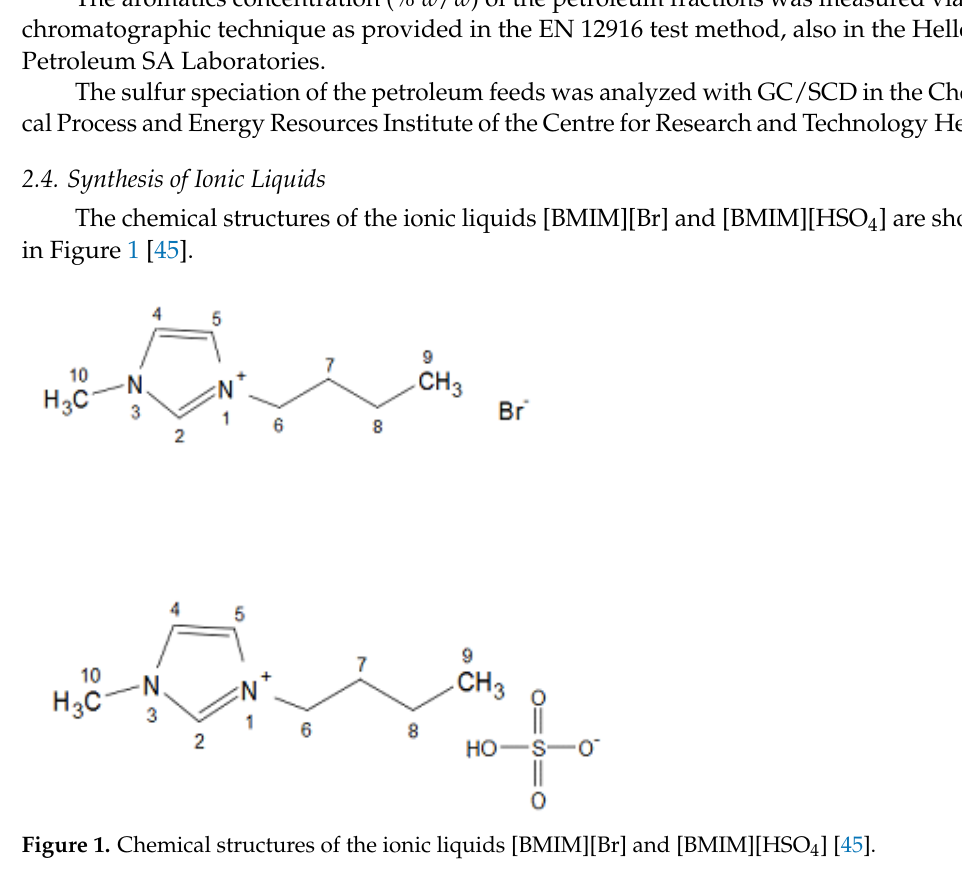
Figure 1. Chemical structures of the ionic liquids [BMIM][Br] and [BMIM][HSO 4 ]